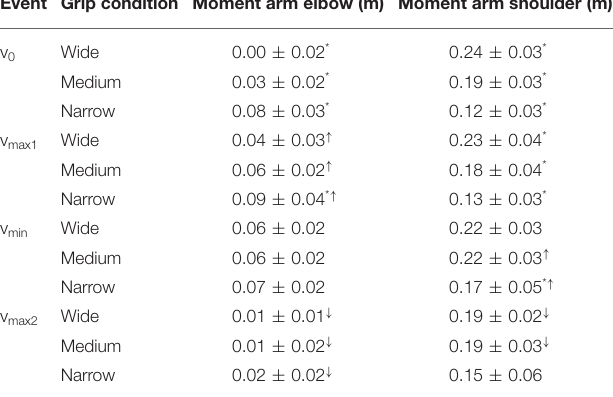
TABLE 2 | Mean ( ± SD) moment arms on elbow and shoulder at the different events in the wide, medium, and narrow grip bench press. Event Grip condition Moment arm elbow (m) Moment arm shoulder